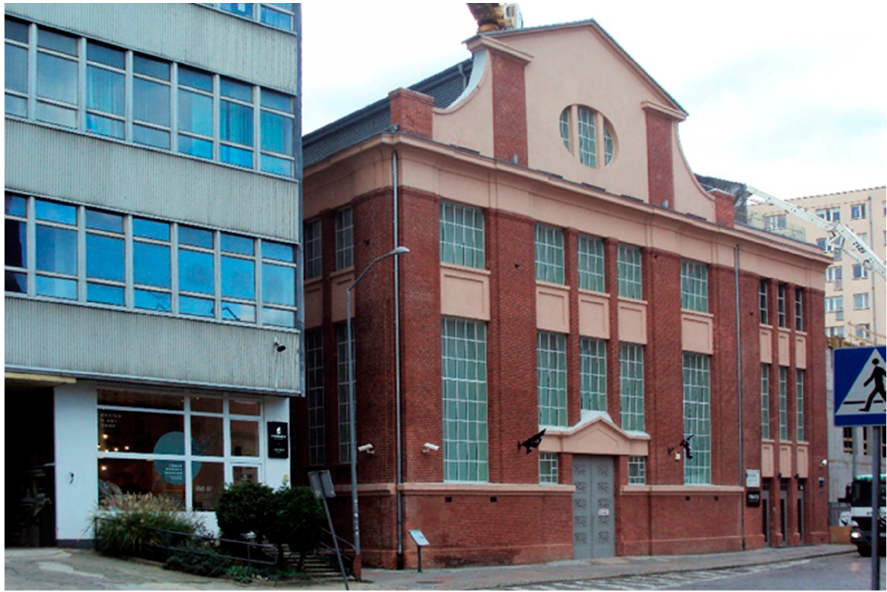
Figure 4. TRAFO Center for Contemporary Art in Szczecin, photo by Hoa binh, Wikimedia Commons, available online: https://commons.wikimedia.org/wiki/File:Szczecin,_transformatorownia_przy_ul._%C5%9Aw._D